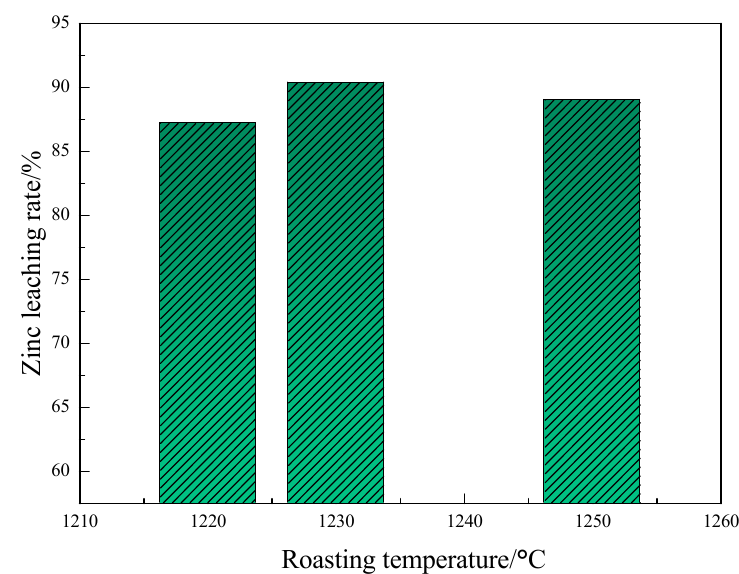
Figure 11. Effect of roasting temperature on zinc leaching rate.